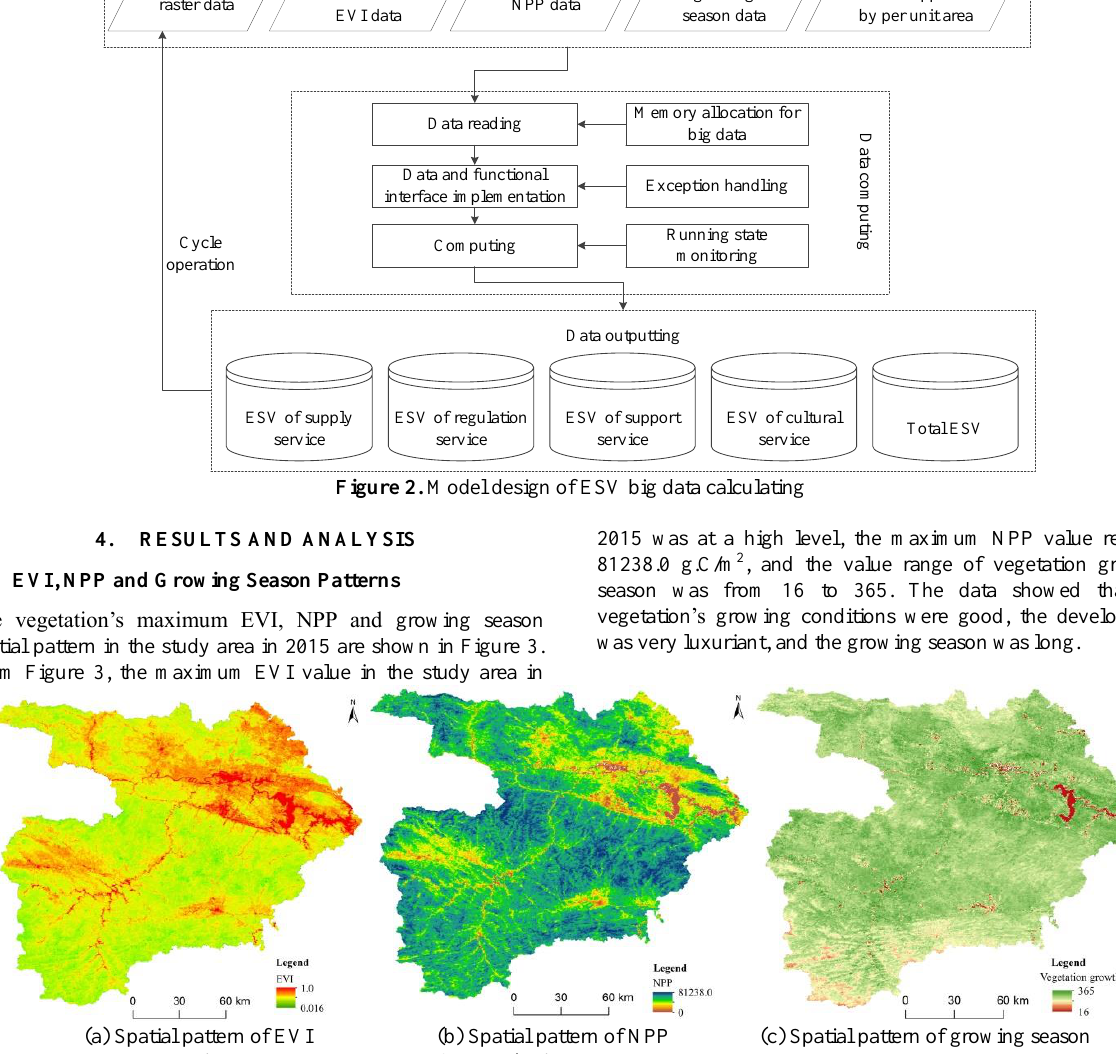
Figure 3. Spatial patterns of vegetation’s EVI, NPP and growing season during 2015